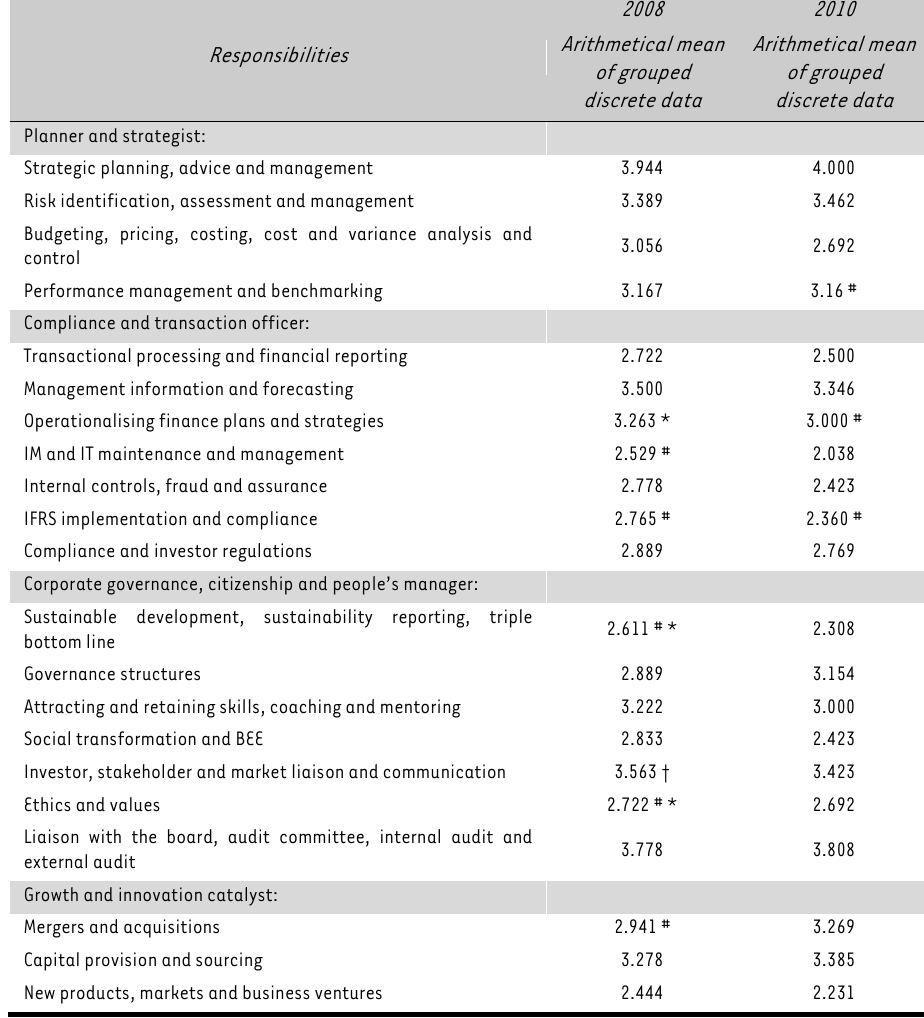
TABLE 13: Comparison of time currently spent on their responsibilities per role